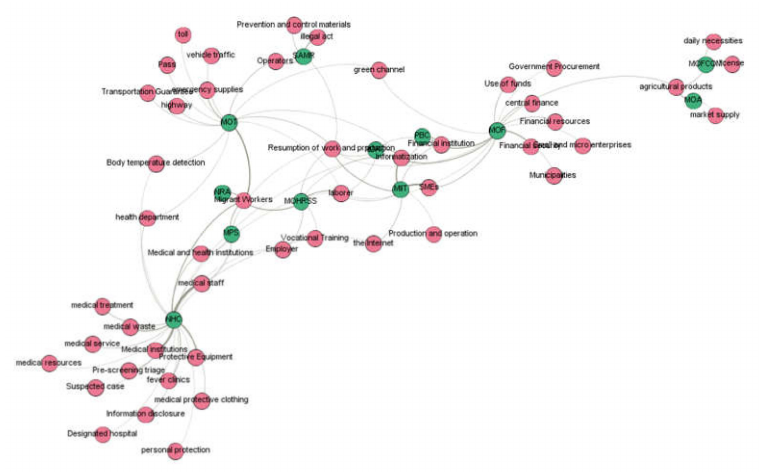
Figure 4. “Agency–topic” relationship network in the first phase. Table 3. Policy topics of interagency collaborative decision-making in the first